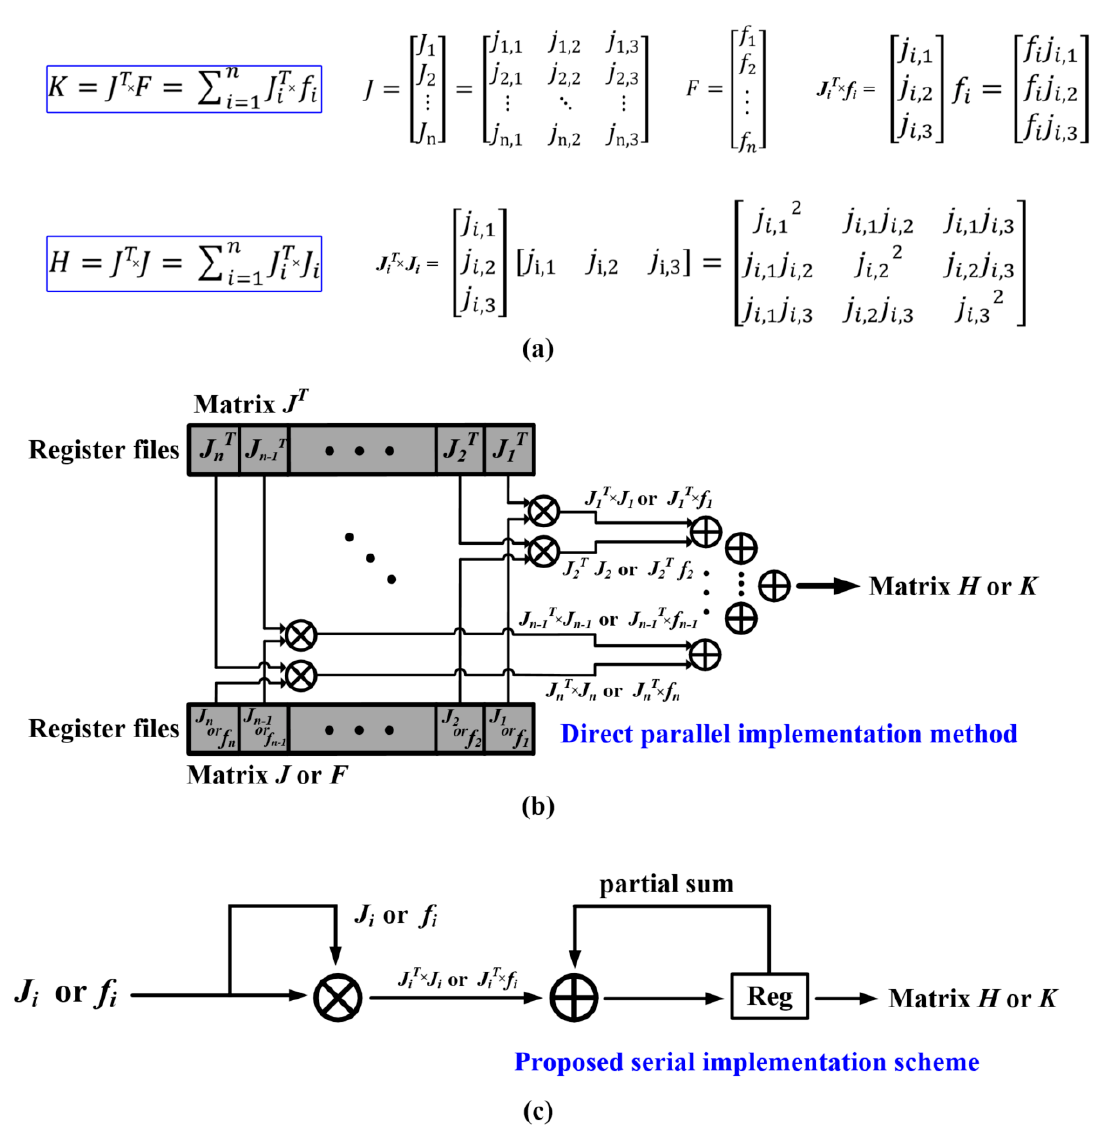
Figure 8. ( a ) Matrix calculation of the H/K matrix; ( b ) direct parallel implementation method; ( c ) proposed serial implementation scheme of the H/K matrix calculation.